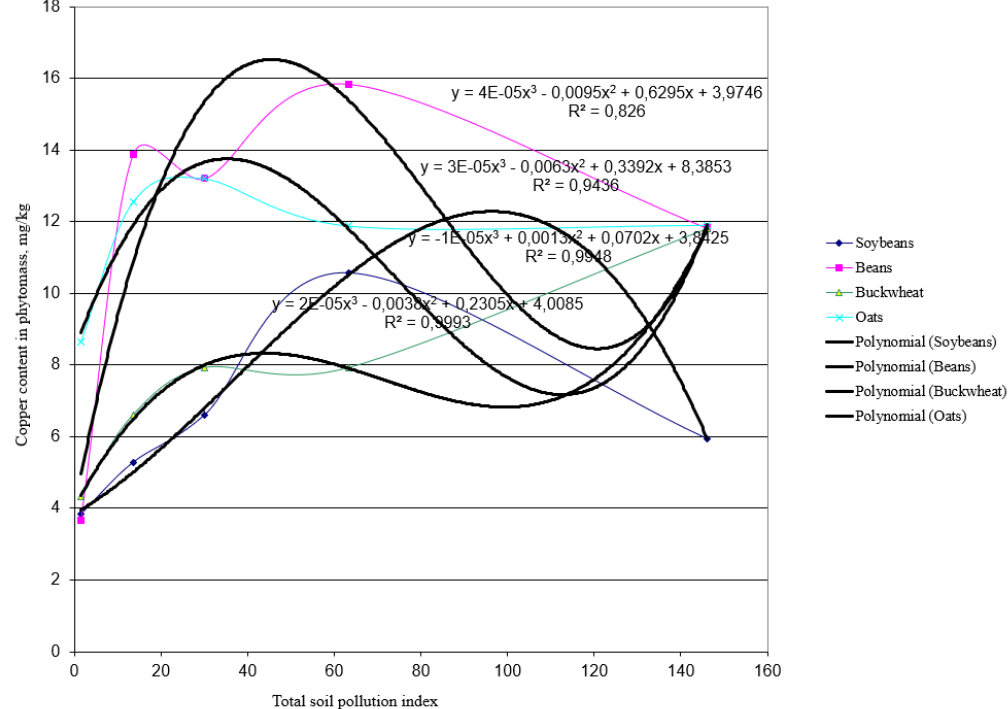
Figure 5. Dependence of copper content in plant phytomass on the level of soil pollution.